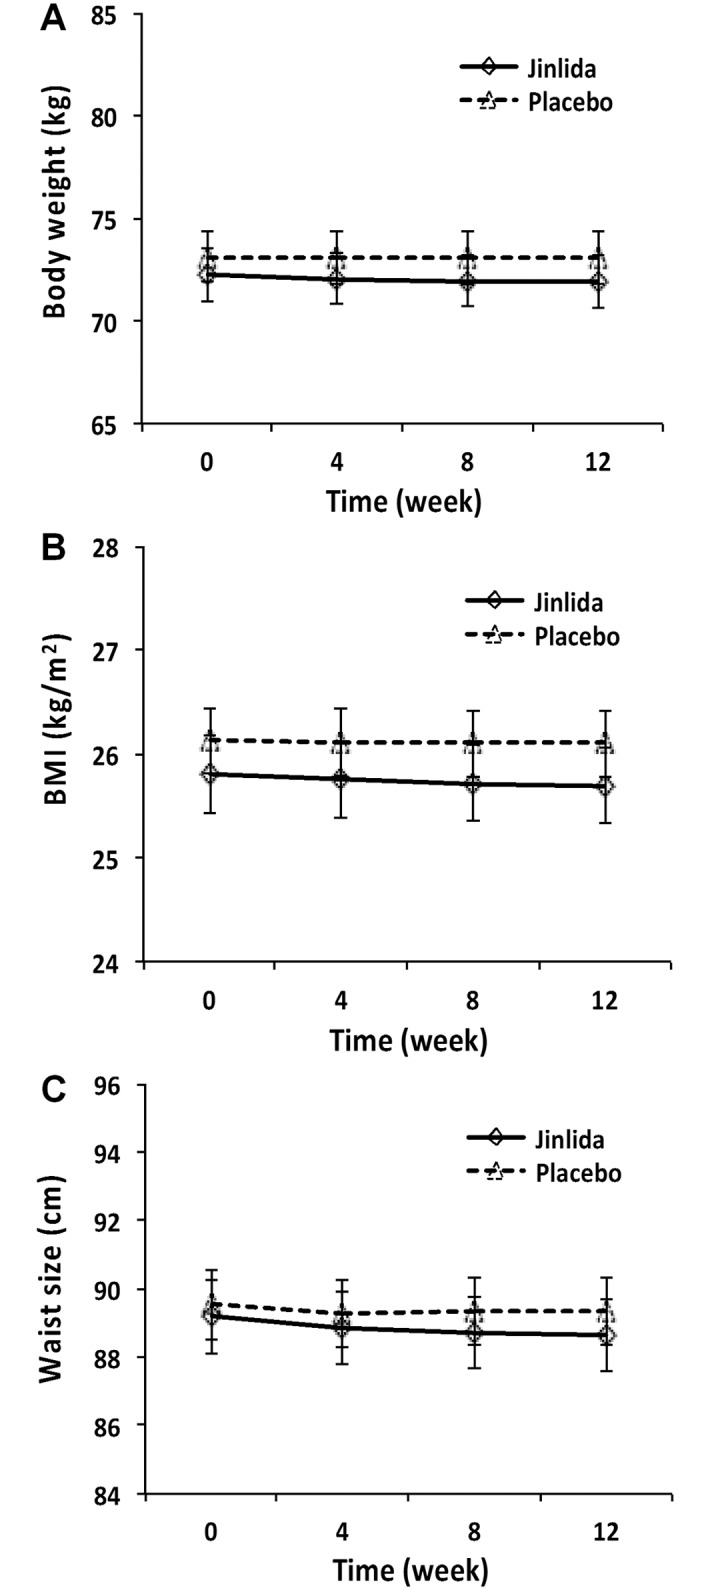
The mean values of body weight, BMI and waist circumference in the Jinlida group and placebo group.After 12 weeks of treatment, the body weight, BMI and waist size did not change significantly between the Jinlida and placebo groups and within the groups.